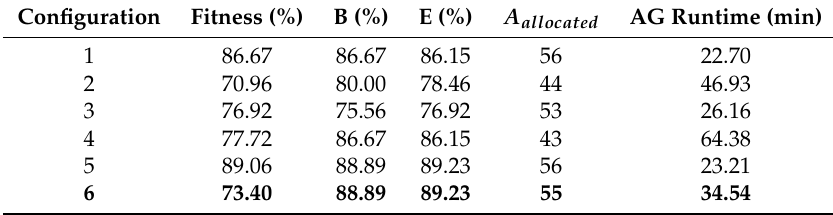
Table 5. Results obtained when simulating a 10 kA lightning discharge at buses B 35 and B 42 . Configuration